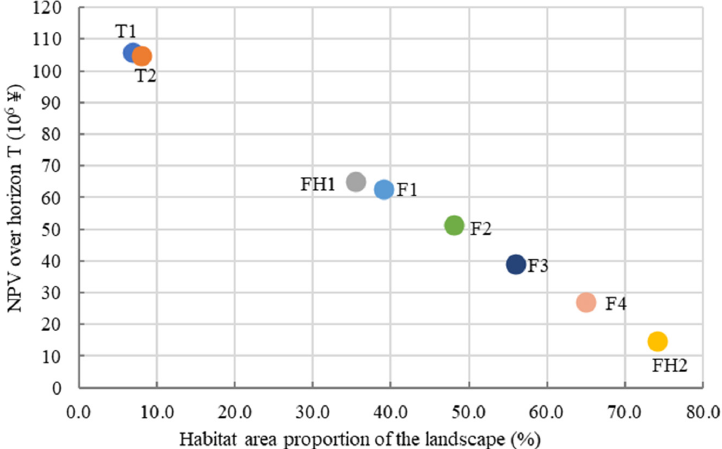
Figure 7. Trade-offs between the optimal solutions for various management strategies in dimen- sions of total timber revenue and the amount of protected suitable habitat for the great spotted woodpecker ( Dendrocopos major ) in the landscape of Maoershan Forest Farm, China. NPV: net pre- sent value. Colored circles represent scenarios within the strategies: timber-oriented management strategy (TMS, scenarios T1 and T2), fixed selection of suitable habitat management strategy (FSSHMS, scenarios FH1 and FH2), and free selection of restricted suitable habitat management strategy (FSRSHMS, scenarios F1 to F4).